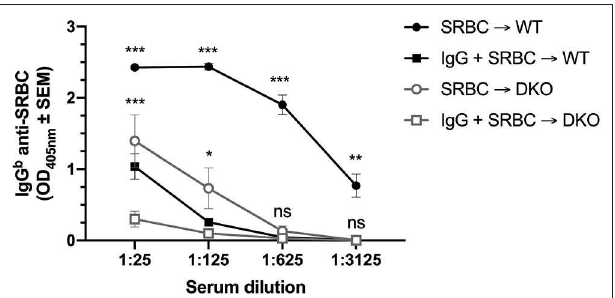
FIGURE 2 | IgG suppresses IgG anti-SRBC responses in (FcR γ × C3) DKO mice. WT or (FcR γ × C3) DKO mice were immunized i.v. with 5 × 10 7 SRBC alone, 30 µ g polyclonal IgG a anti-SRBC alone, or with 30 µ g polyclonal IgG a anti-SRBC + 5 × 10 7 SRBC ( n = 9 or 10 mice/group). Sera obtained 20 days after immunization were tested in ELISA. IgG anti-SRBC levels in WT or DKO mice immunized with IgG alone were similar to levels in the blanks (not shown). Statistical differences between the groups were determined by two-way ANOVA. Statistical differences between WT mice immunized with SRBC or IgG + SRBC are shown above the upper curve (black) and statistical differences between DKO mice immunized with SRBC or IgG + SRBC above the middle curve (gray). *** p < 0.001; ** p < 0.01; * p < 0.05. The data shown are pooled from two separate experiments. The experiment was performed an additional time, using a 10-fold lower dose (5 × 10 6 SRBC/mouse) and 30 µ g IgG a anti-SRBC: WT mice were suppressed down to a serum dilution of 1:625 and DKO mice suppressed at a serum dilution of